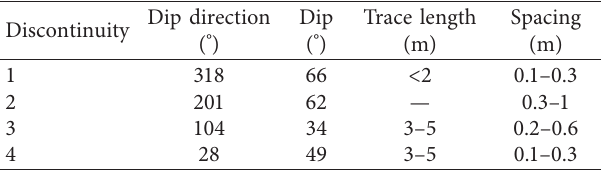
Table 1: Characteristics of the surveyed discontinuity sets in the study